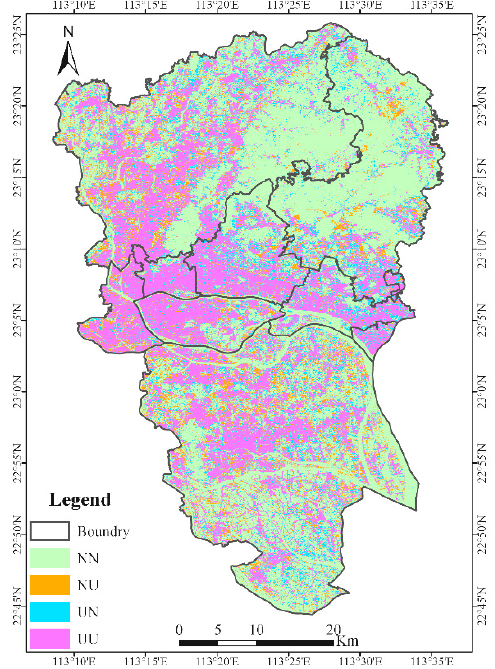
Figure 4. Different types of land use changes in the study area from 2007 to 2017. Figure 4. Di ff erent types of land use changes in the study area from 2007 to